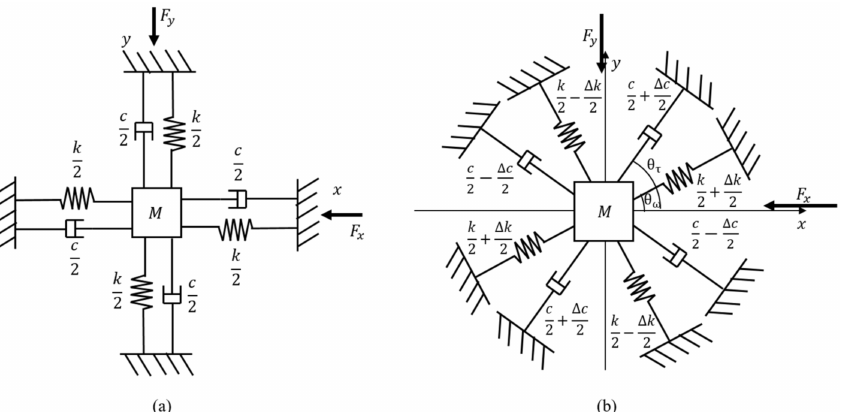
Figure 2. Lumped element models of hemispherical resonators; ( a ) ideal symmetric resonator model, and ( b ) general resonator model having asymmetry in stiffness and damping. M : mass, c : damping constant, ∆ c : damping constant difference, θ τ : damping axis angle, k : spring constant, ∆ k : spring constant difference, θ ω : spring axis angle, F x : driving force in x direction, F y : driving force in y